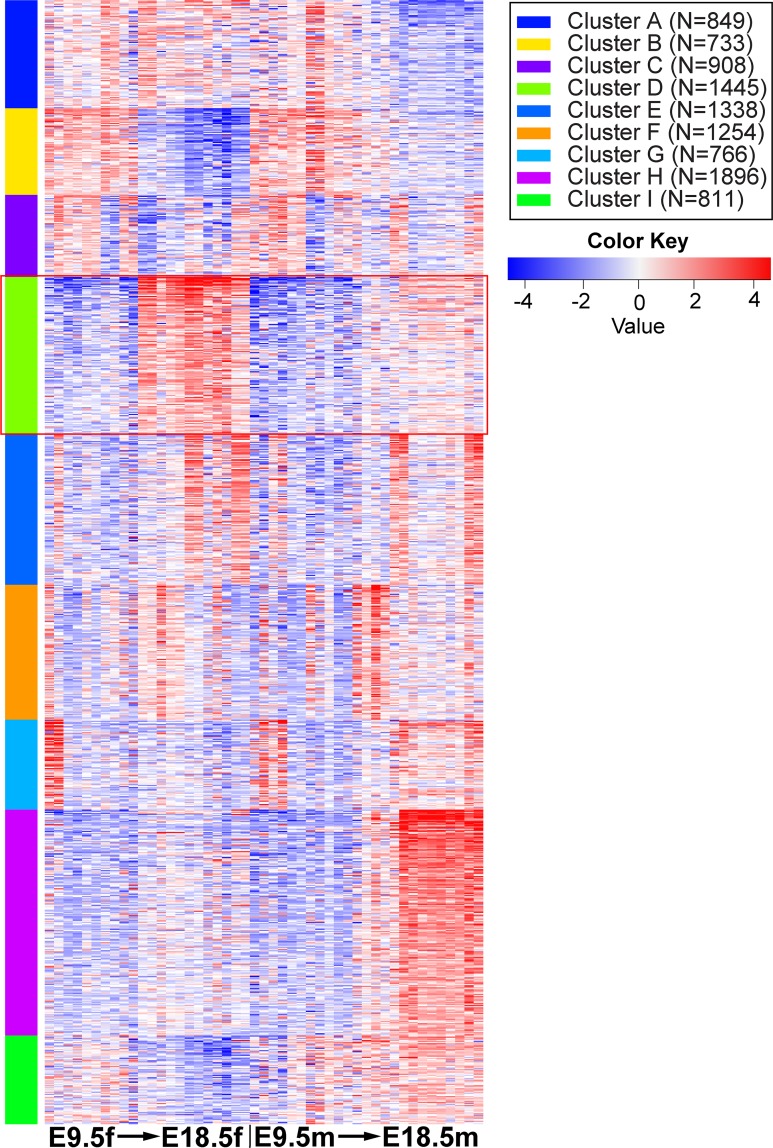
K-means clustering of female and male germ cell samples in Oct4-EGFP mouse time course.Heatmap generated based on clustering the top 10,000 most variable genes in the dataset into 9 clusters. Red box around Cluster D to identify Taf4b-containing group of genes.